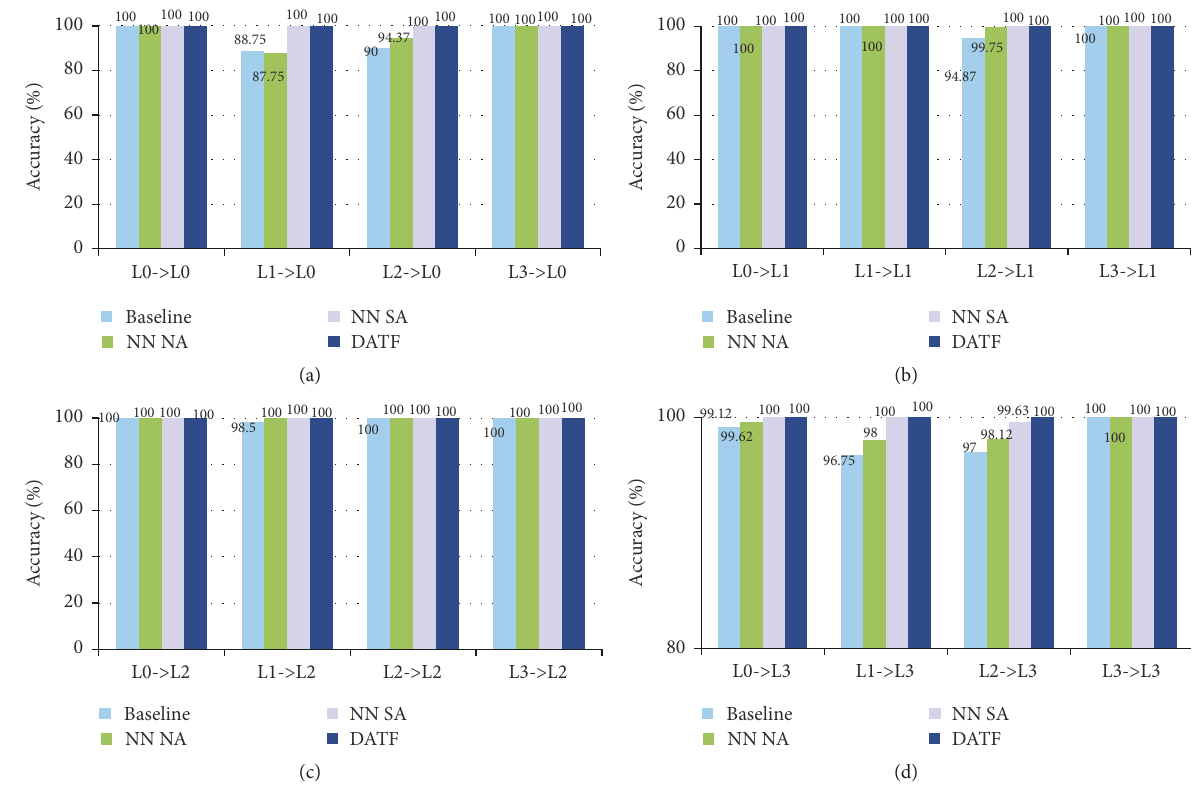
Figure 5: The results with fault size being